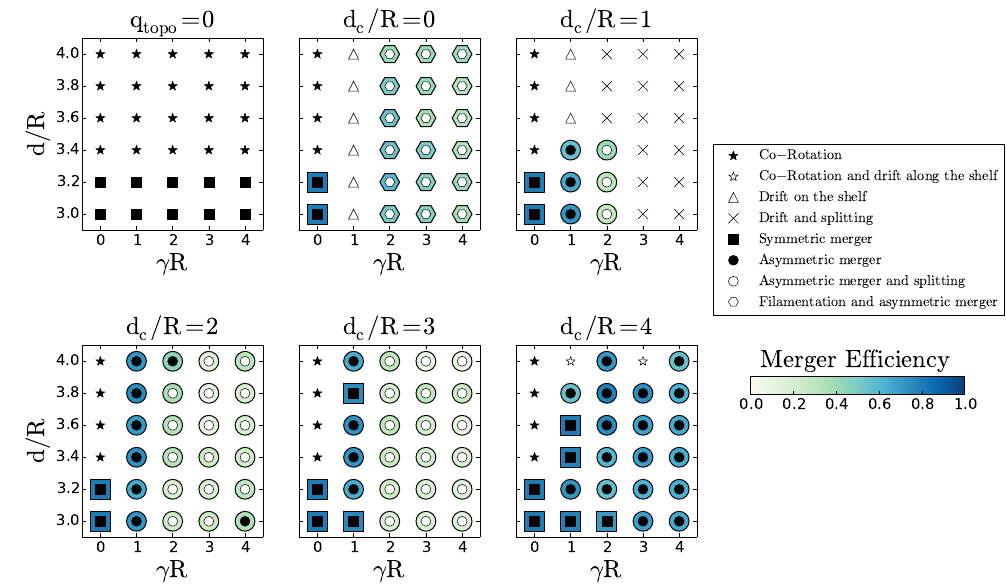
Figure 13. Regime diagram for the interaction of two surface cyclones given d c / R (see above each plot), in the γ R , d / R plane, for f 0 h b 0 / H 2 = 0.6. Black stars indicate co-rotation; white stars represent co-rotation and drift along the shelf/slope; black squares indicates symmetric merger; black circles represent asymmetric merger; white circles denote asymmetric merger and vortex splitting; triangles represent drift towards and on the slope and shelf; hexagons indicate filamentation and asymmetric merger; and crosses denote vortex drift and splitting. The blue shading provides the value of the merger efficiency, when